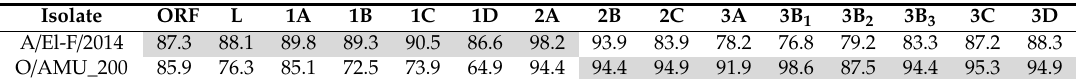
Table 2. Pairwise nucleotide identity between the 2016 serotype A isolate from this study (sample 10) and A / El-Fayoum / Egypt / 2014 (accession# KP940474) or O / AMU_200 / Uganda / 2017 (accession# MH791293), respectively. Apart from the comparison across the entire ORF, each coding region was compared separately. For each region, the more similar strain is highlighted in gray.